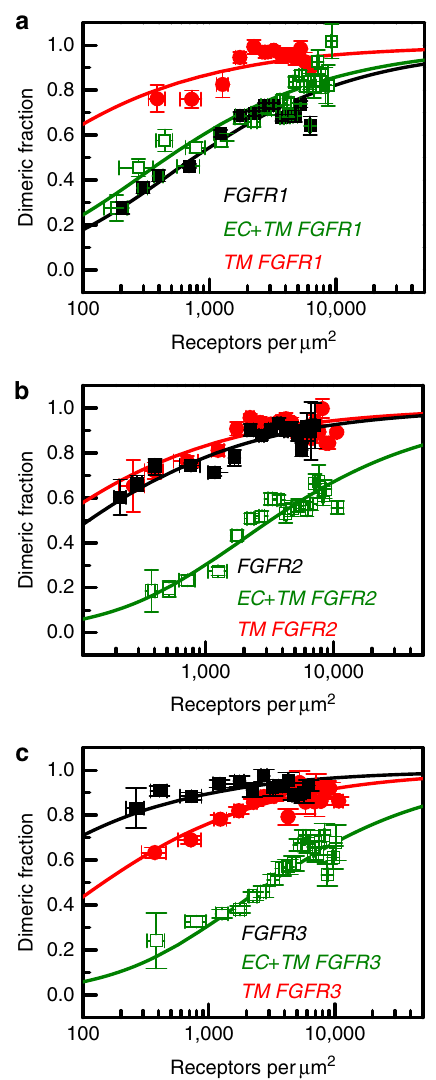
Figure 2 | FGFR domain contributions to unliganded dimerization. Dimerization curves are shown for the full-length receptors (black), for truncated receptors that lack the IC domain and thus contain only the EC and TM domains (olive), and for the TM domains only (red). ( a ) FGFR1. ( b ) FGFR2. ( c ) FGFR3. Data for EC þ TM FGFR3 and TM FGFR3 are from ref. 36. The measured dimeric fractions are binned and are shown with the symbols, along with the standard errors. Each bin contains between 5 and 50 experimental points. The solid lines are the best fits of a monomer– dimer equilibrium model to the single-vesicle data. These data demonstrate that the TM domains have a strong propensity for dimerization. The EC domains, on the other hand, inhibit dimerization. The contribution of the IC domains is favourable, but it varies from zero to (cid:2) 3kcalmol (cid:2) 1 for the three